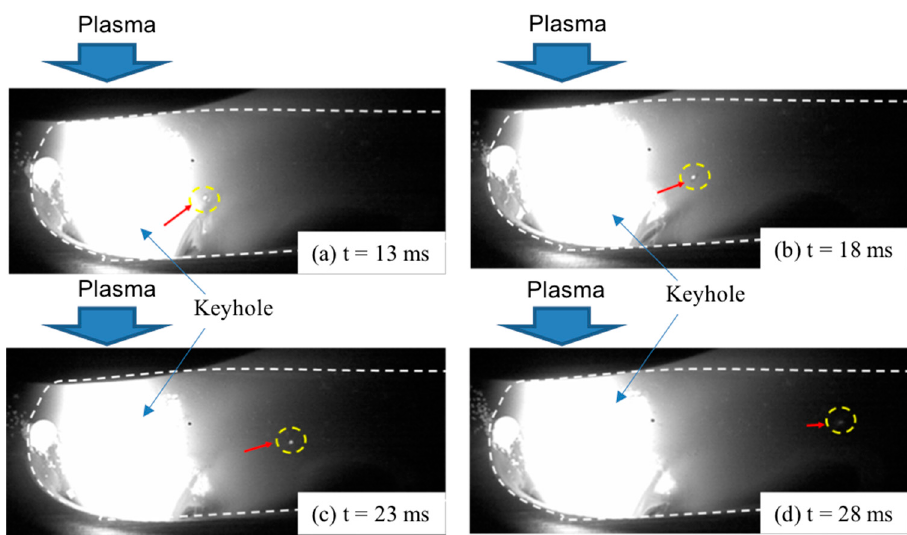
Figure 9. Typical continuous tracer particle movement images. ( a ) t = 13 ms, ( b ) t = 18 ms, ( c ) t = 23 ms, ( d ) t = 28 ms.